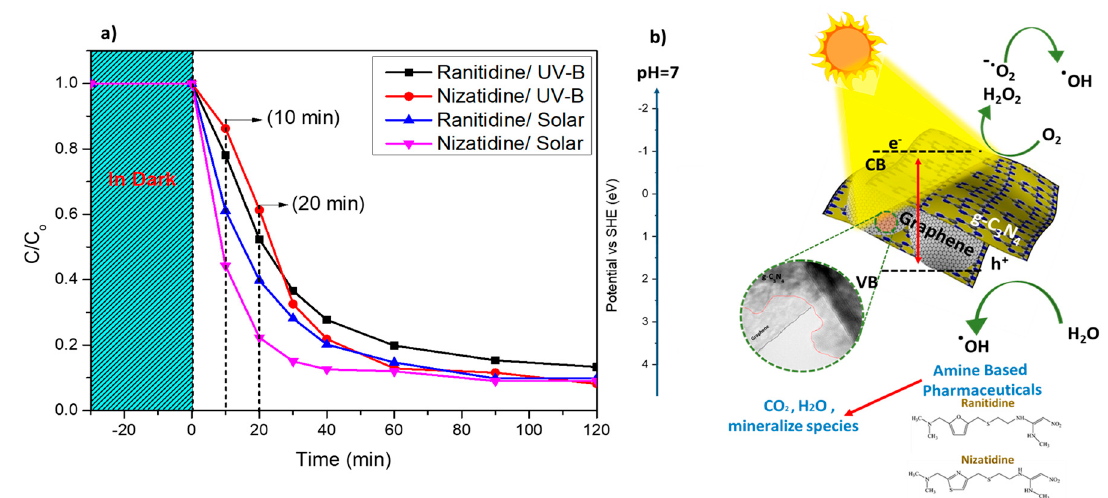
Figure 9. ( a ) C/C o Plots for nizatidine and ranitidine under UV and Solar irradiation. ( b ) the photocatalytic mechanism under solar light.